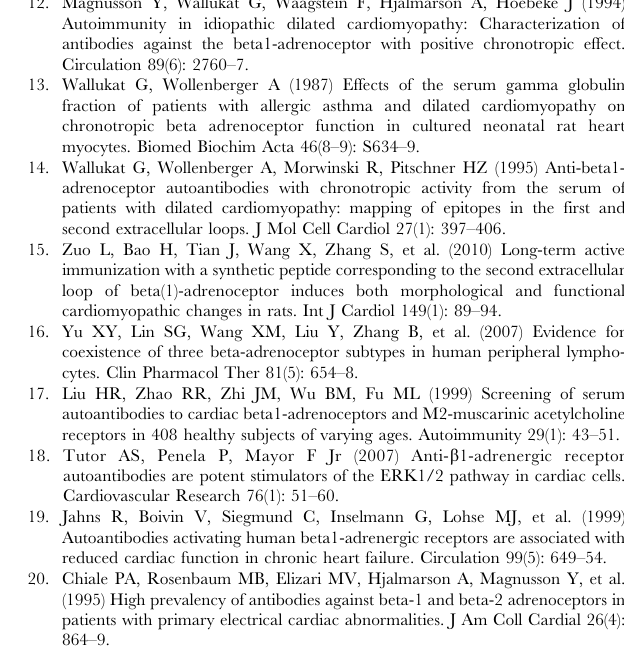
Figure S7 The proliferation of CD3 + T lymphocytes induced by b 1 -AA was blocked by b 1 -AR-EC II . The supernatant produced by incubating b 1 -AA with b 1 -AR-EC I promoted CD3 + T lymphocytes proliferation. The proliferation of CD3 + T lymphocytes induced by b 1 -AA was blocked by b 1 -AR- EC II . ** p , 0.01, * p , 0.05 versus. vehicle group. n = 6 per group. Data are presented as means 6 SD of 3 independent experiments. (TIF) Figure S8 The IgGs isolated from healthy subjects revealed no effect on the levels of IFN- c and IL-4 in CD3 + T cells. n = 6 per group. Data are presented as means 6 SD of 3 independent experiments. (TIF) Figure S9 The reduce of IFN- c induced by b 1 -AA- negative IgG was partially blocked by b 1 -AR-EC I . b 1 - AA-negative IgG (25 m g/ml) and the peptide corresponding to the sequence of the first extracellular loop of the human b 1 -AR ( b 1 - AR-EC I , 1 m mol/l) co-incubated for 1 h at 37 u C, supernatants were then collected to treat CD3 + T lymphocytes, and finally IFN- c level was analyzed by ELISA. ** p , 0.01, * p , 0.05 versus. vehicle group; DD p , 0.01 versus negative IgG group. n =6 per group. Data are presented as means 6 SD of 3 independent experiments.